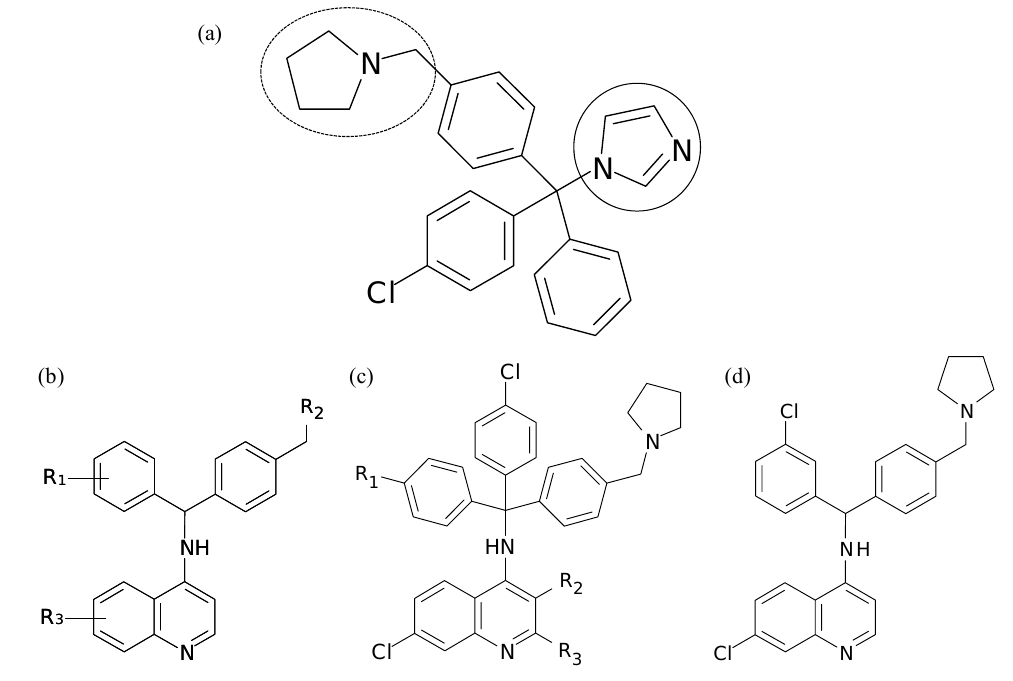
Figure 8. Novel clotrimazole-based antimalarial compounds. (a) A typical clotrimazole derivative showing imidazole (solid ring) and protonatable amine (dashed ring) [73]. Generalised hybrid compounds combining a 4-aminoquinoline nucleus with (b) a simplified benzhydryl moiety or (c) the triarylmethyl moiety of clotrimazole. (d) The 4- aminoquinoline-benzhydryl analogue chosen for preclinical